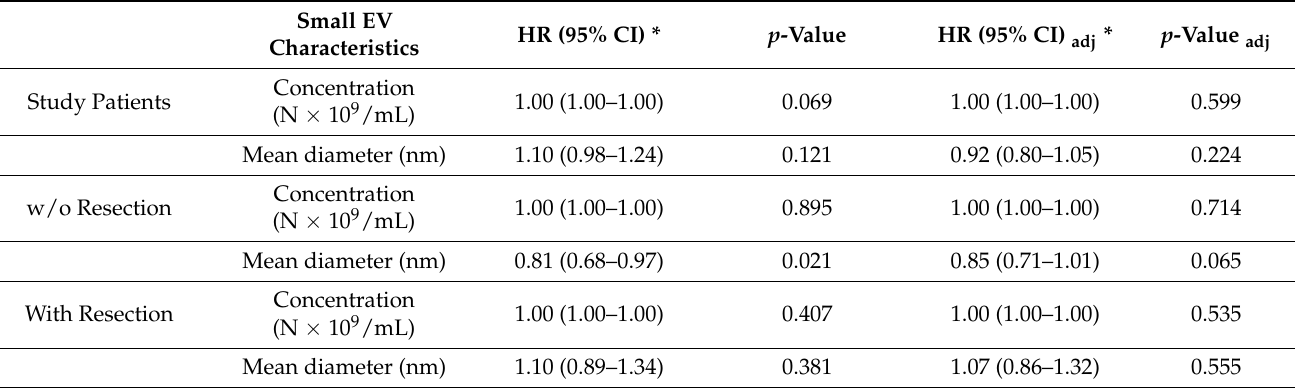
Table 3. Association of sEV characteristics before surgery with